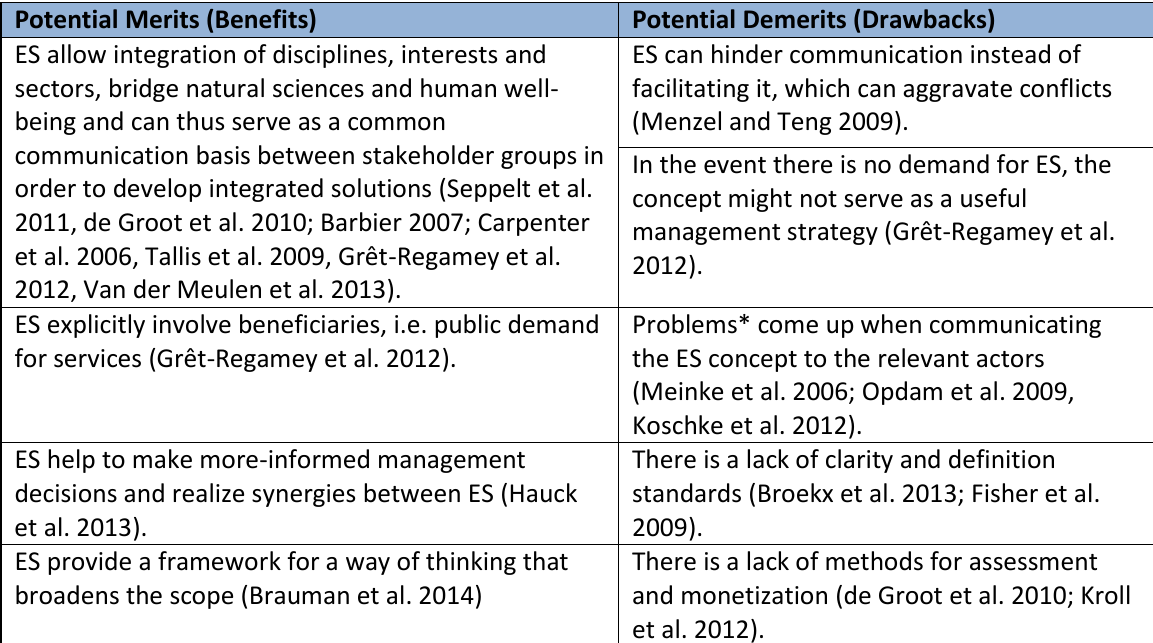
Table 1: Summary of potential merits and demerits of applying the ES concept in participatory processes in management and planning practice, based on ES literature. Potential Merits